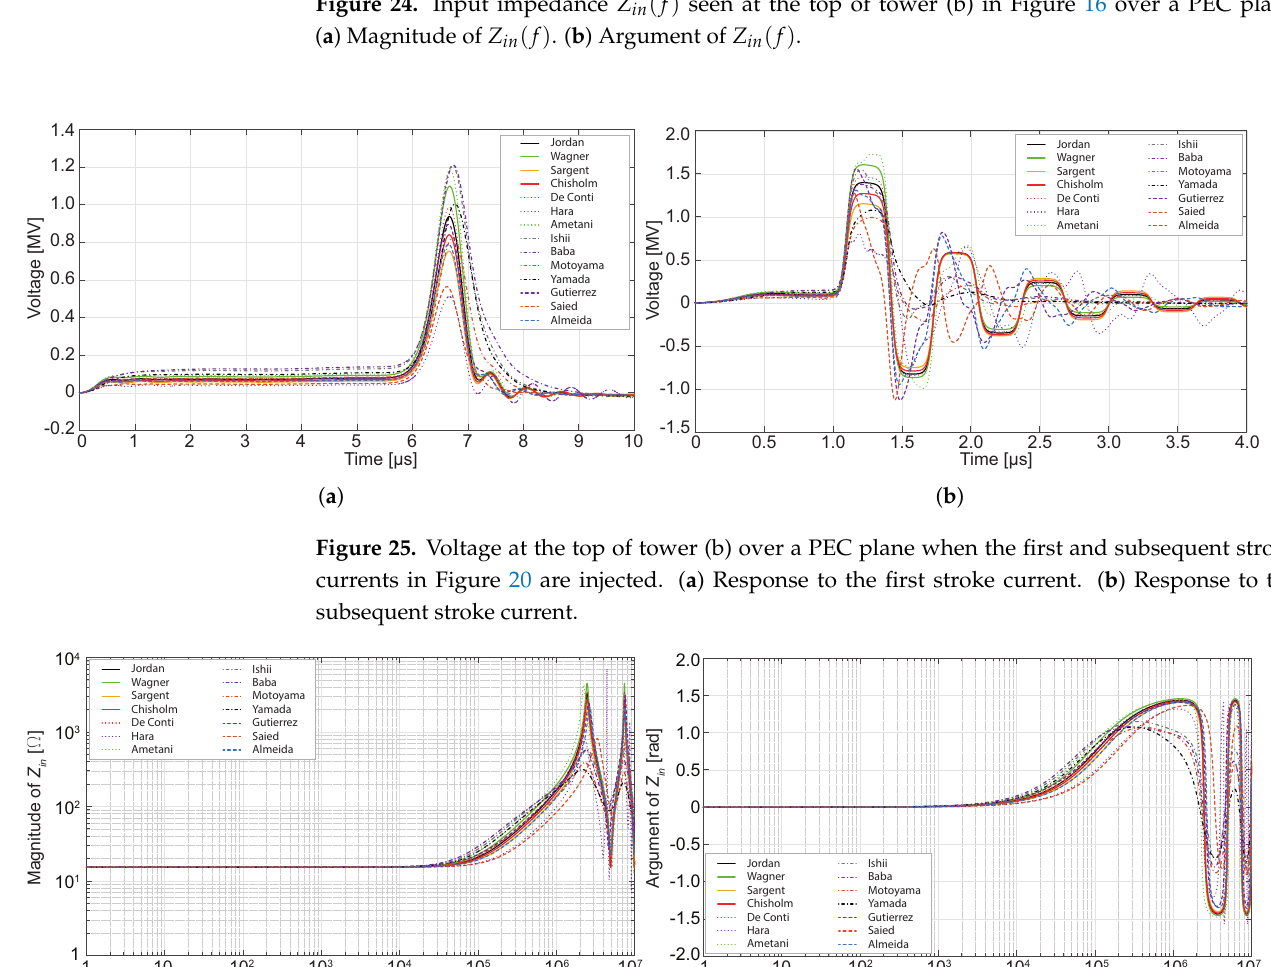
( f ) . ( b ) Argument of Z ( f ) in in